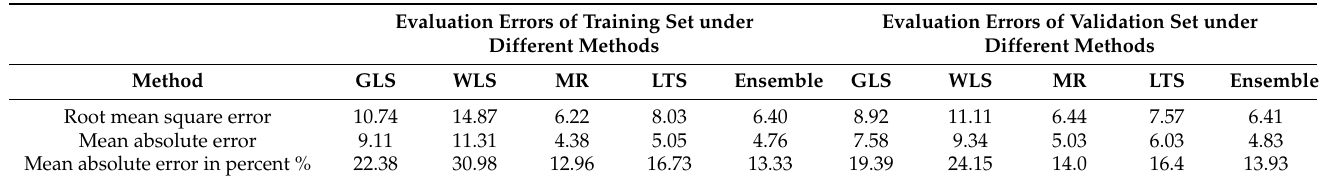
Table 7. Evaluation errors of training set and validation set under different methods.